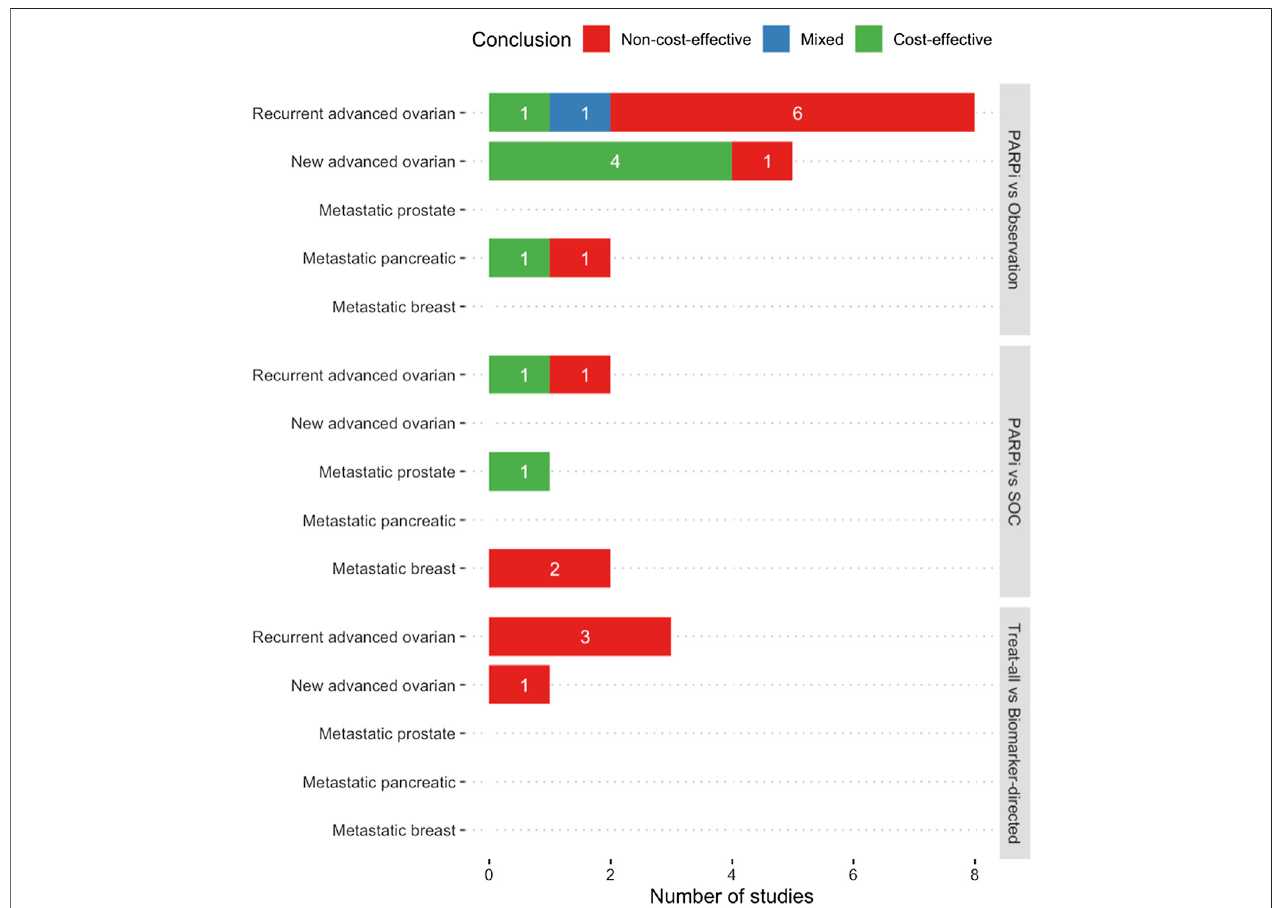
FIGURE 2 | Summary of economic evaluation outcomes of included studies (a,b). (a) Mixed conclusion indicates the presence of both positive and negative conclusion for cost-effectiveness in different comparison arms in the same study. (b) PARPi vs Observation = Any PARP inhibitors were compared against observation, routine surveillance, or placebo, which all mean no maintenance therapy after standard chemotherapy. PARPi vs SOC = Any PARP inhibitors were compared against standard chemotherapy or hormone therapy. Treat-all vs Biomarker-directed = An approach when any PARP inhibitors were given to all patients without genetic characterization, compared with treatment on selective patients guided by the results of genetic tests. Abbreviations: PARPi − PARP inhibitors, SOC − Standard of care.